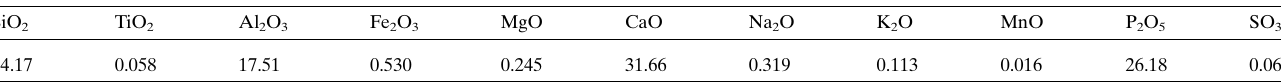
Table 3 X-ray fluorescence (XRF) analysis (%) of natural